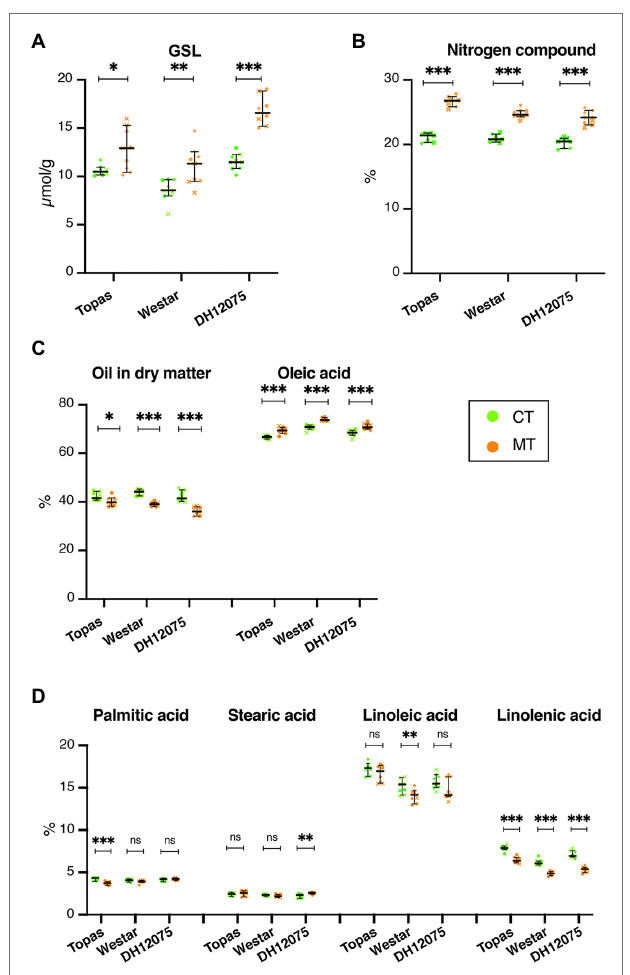
FIGURE 9 | Differences in Glucosinolates (GSL), Nitrogen, and seed oil levels induced at MT. (A–D) Graphs are displaying the levels of glucosinolates (GSL in 9% humidity, μ mol/g; A ), nitrogen compound (%; B ), total oil in dry matter (%) and oleic acid (% of total oil; C ), palmitic acid (% of total oil), stearic acid (% of total oil), linoleic acid (% of total oil) and linolenic acid (% of total oil; D ) at CT (green) and MT (orange) in Topas, Westar and DH12075 cultivars. The data from three biological replicates are plotted (•, replicate 1; ×, replicate 2; ♦ , replicate 3). The horizontal line represents the median with 95% CI. Asterisks indicate statistically significant difference in MT in a paired Student’s t -test ( t -test; * , ** , and *** correspond to value of p 0.05 > p > 0.01, 0.01 > p > 0.001, and p < 0.001, respectively). Source data are found in Supplementary Table S6 . The measurements were done in three biological replicates, each in three technical replicates.